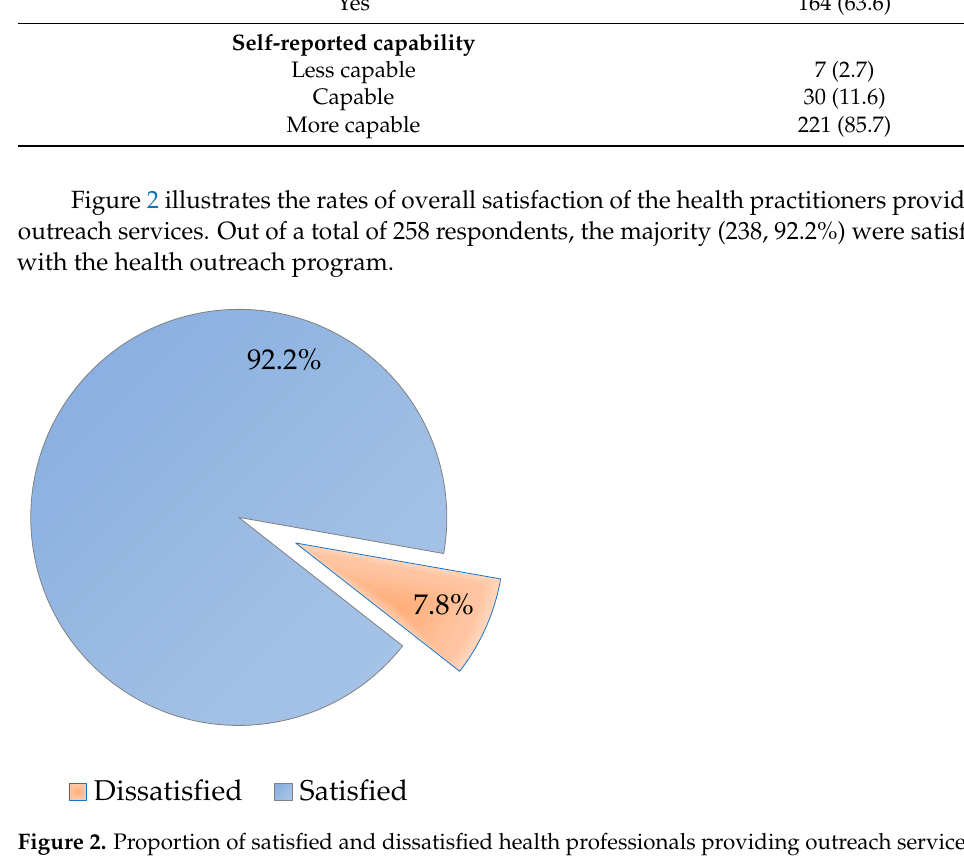
Figure 2. Proportion of satisfied and dissatisfied health professionals providing outreach services to rural communities in NSW and the ACT during the first 2 years of the COVID-19 pandemic.